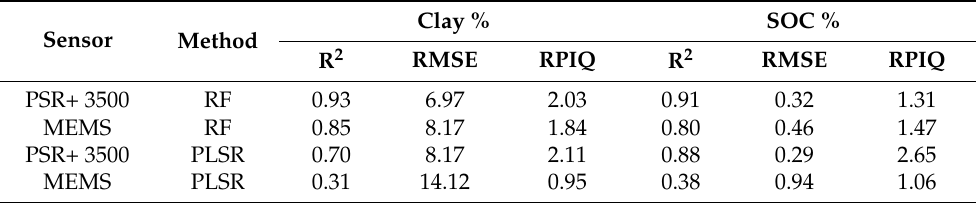
Table 3. Evaluation metrics for the fitted models for Clay and SOC